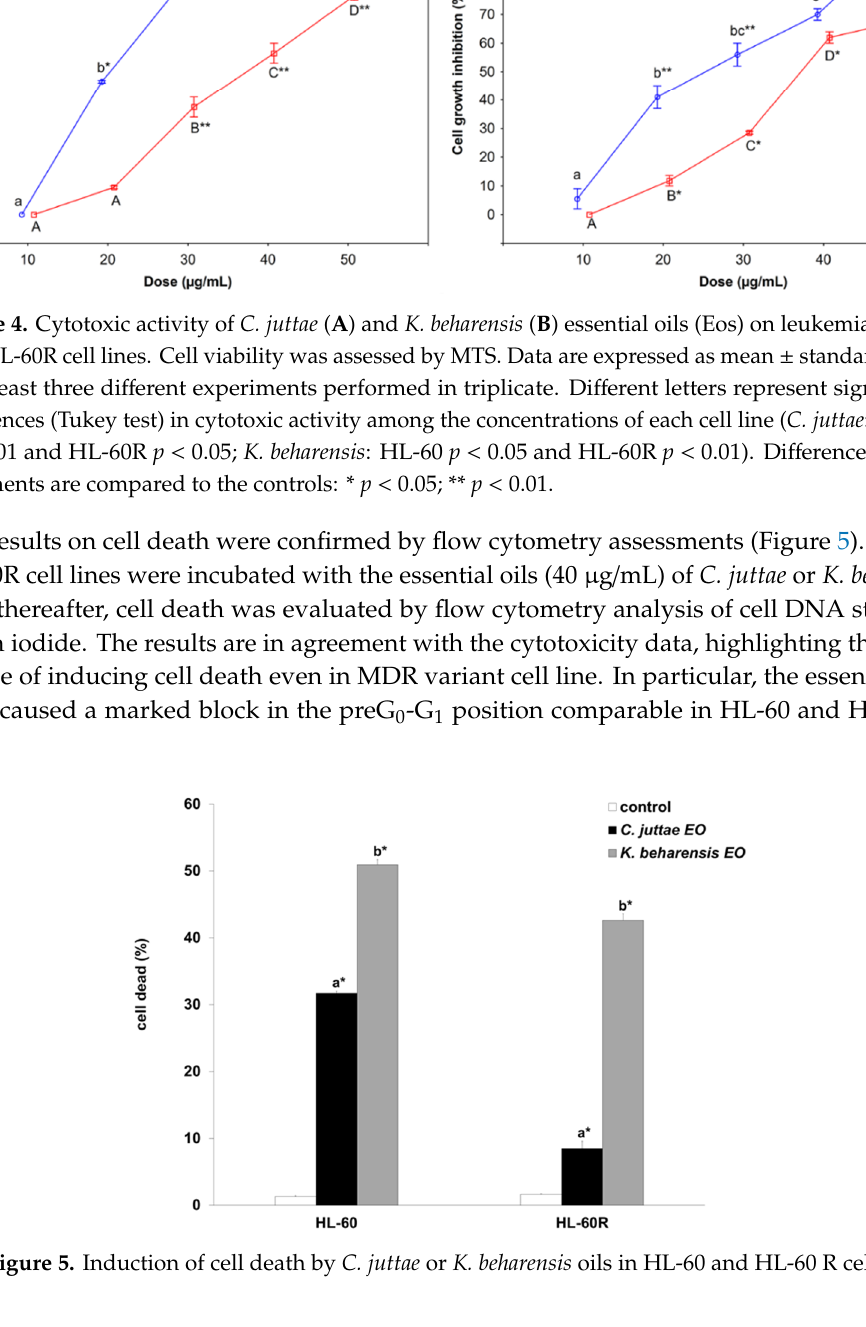
Figure 5. Induction of cell death by C. juttae or K. beharensis oils in HL-60 and HL-60 R cells.